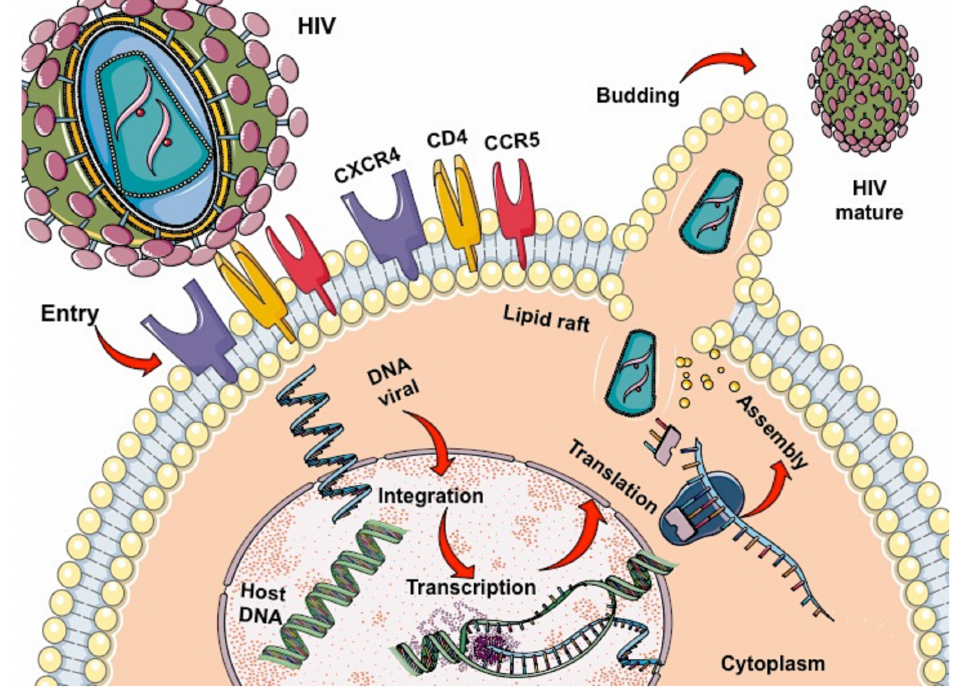
Figure 1. Lifecycle of HIV: binding, fusion, reverse transcription, integration, replication, assembly, budding, and